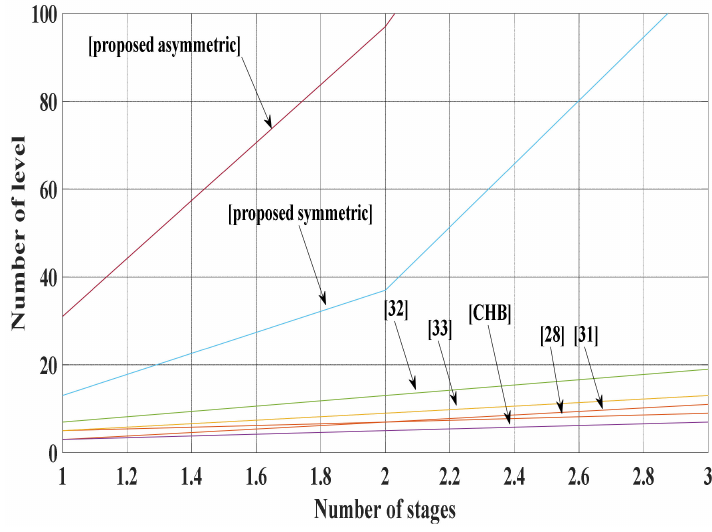
Figure 10. Variation in number of leVels with number of stages.